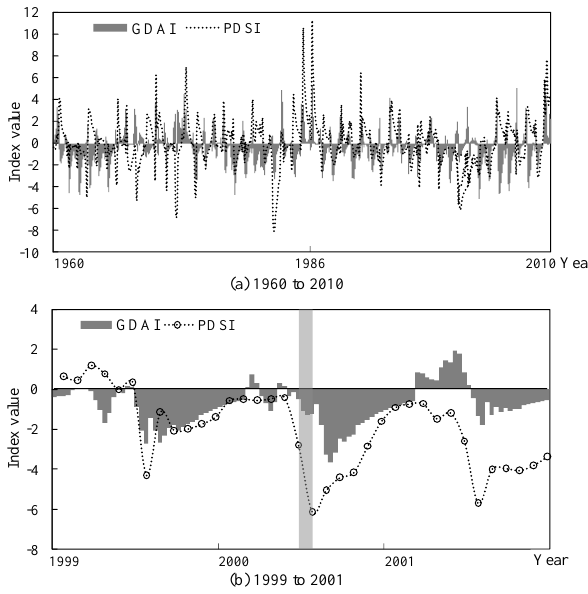
Figure 12. Compared the GDAI with the PDSI in Lishu County.